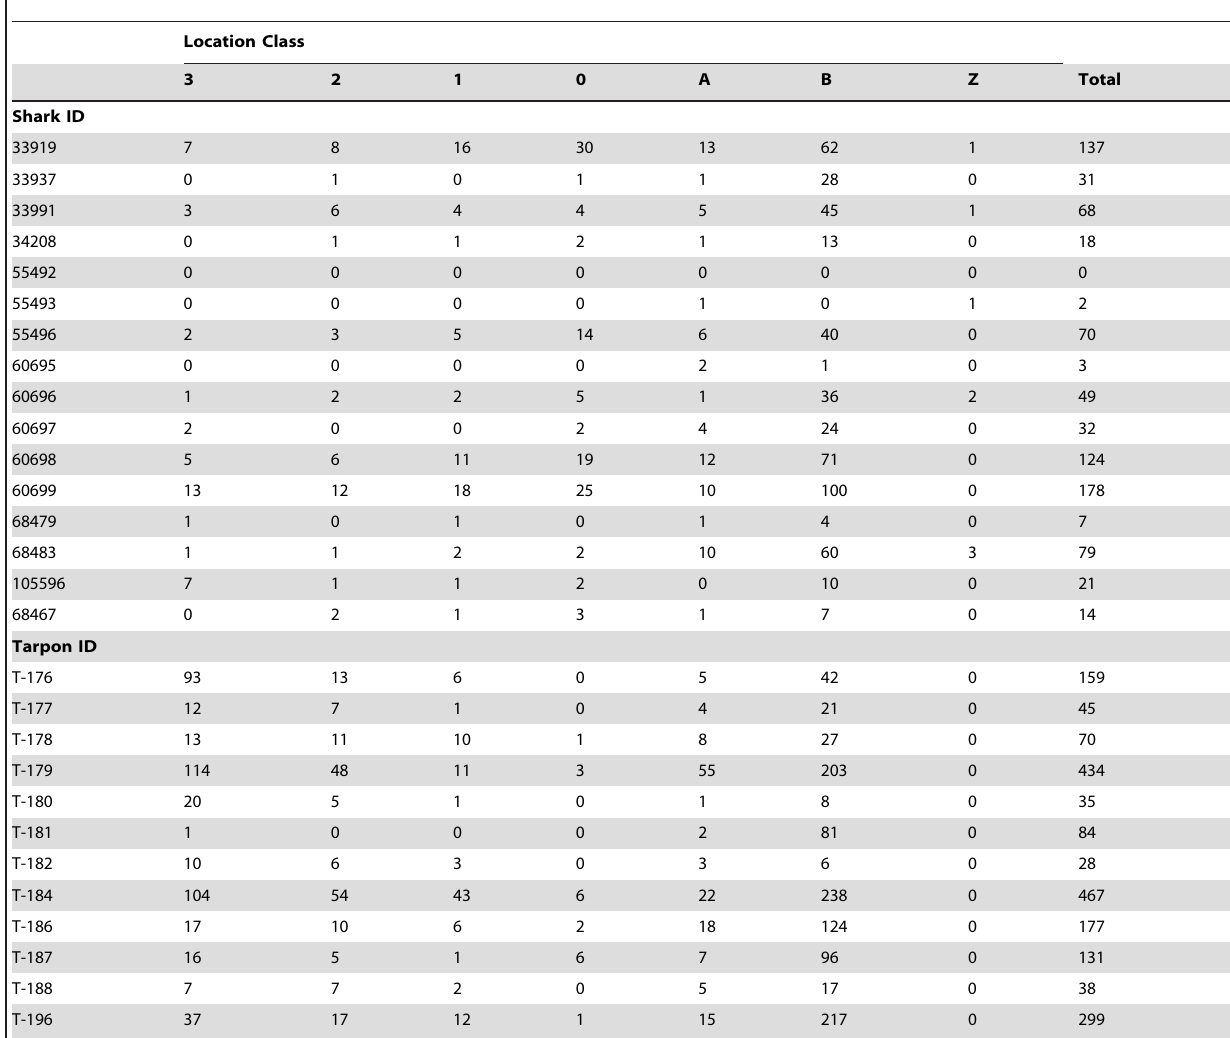
Table 2. Total positions received and corresponding accuracy for each tagged